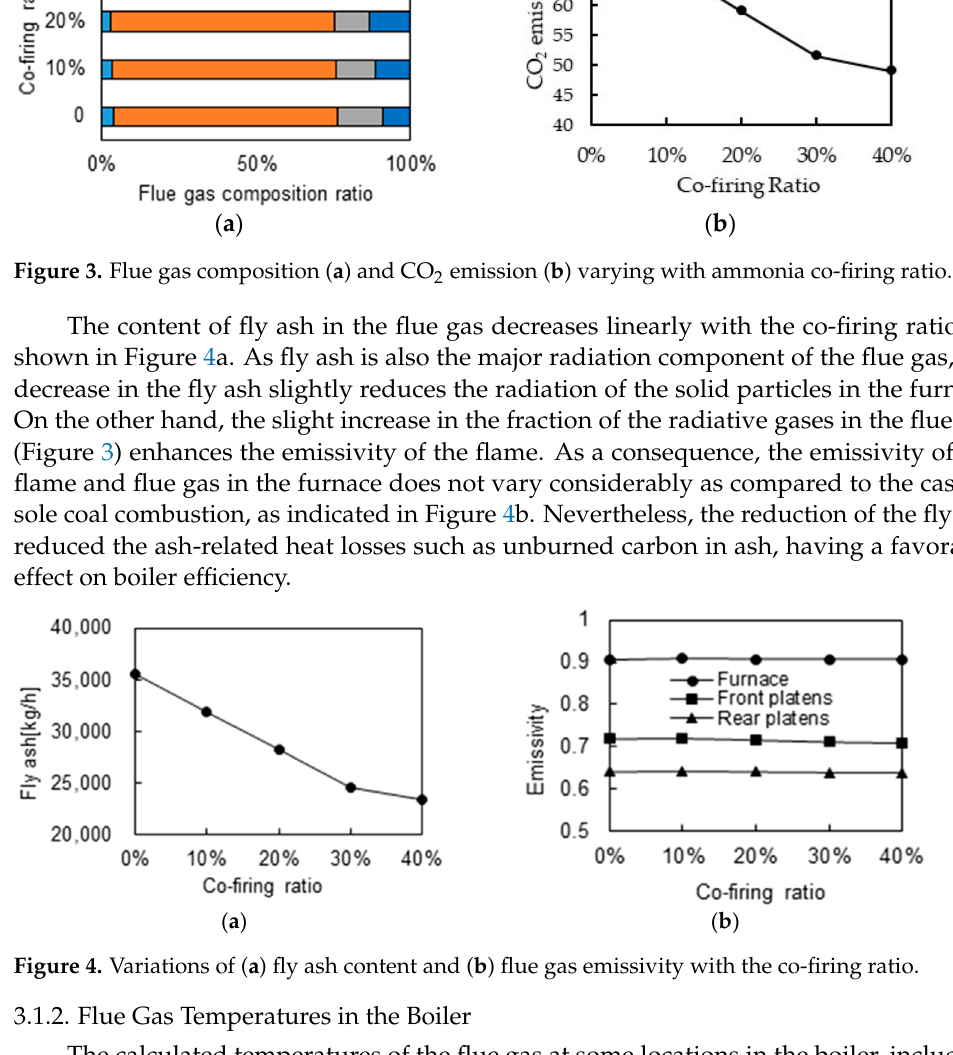
( d ) Figure 5. Effect of ammonia co-firing on the gas temperatures in the boiler, ( a ) adiabatic flame tem- perature and flue gas temperatures at ( b ) furnace exit, ( c ) economizer outlet and ( d ) boiler exit. As can be seen in Figure 5a, the adiabatic flame temperature in the furnace declines with the increase in co-firing ratio and it decreases by about 50 °C at 40% co-firing as compared to that of coal combustion. The main cause is the increase in the heat capacity